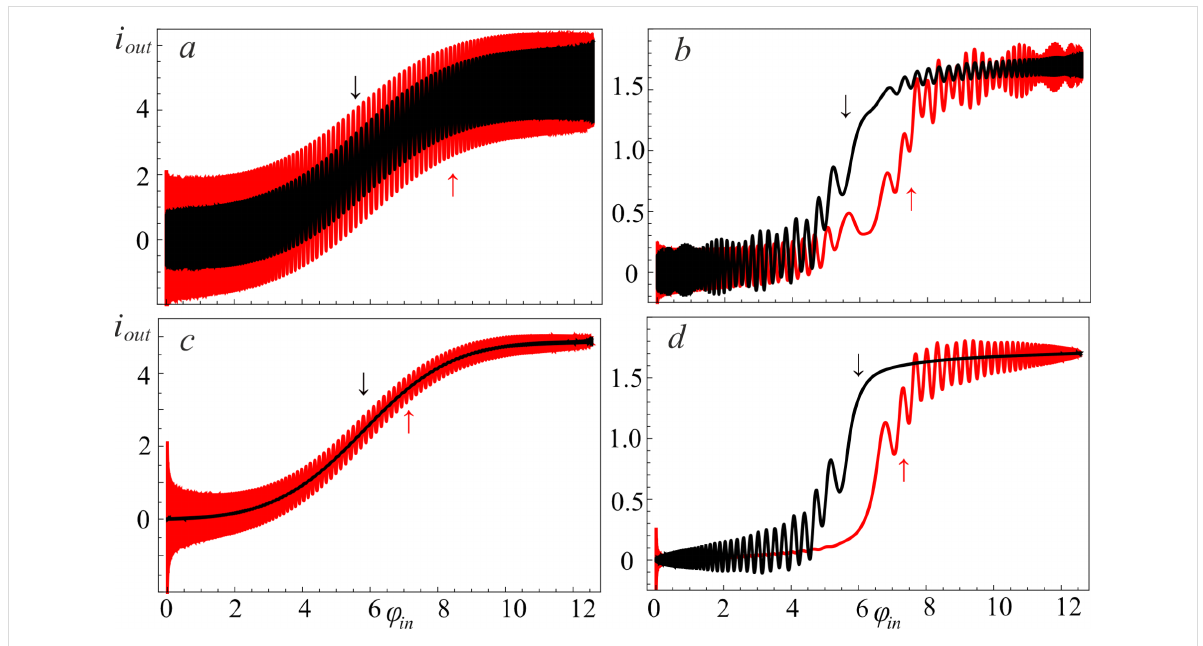
Figure 11: The neuron activation functions for l = 0.1 (a, c) and l = 2.5 (b, d) for different renormalized coupling constants: λ = 0.005 (a, b) and λ = 0.035 (c, d). The input flux parameters are as follows: D = 0.008, A = 4 π , t 1 = 500; the temperature of the bosonic thermostat is T = 50 mK; the cell is initialized in the superposition of the two basic